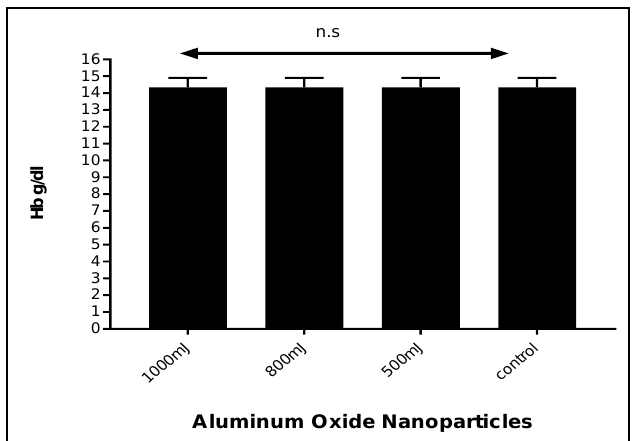
Figure 10: HGB level in blood samples in the presence and absence of Al 2 O 3 NPS at different energy (500, 800, and 1000)